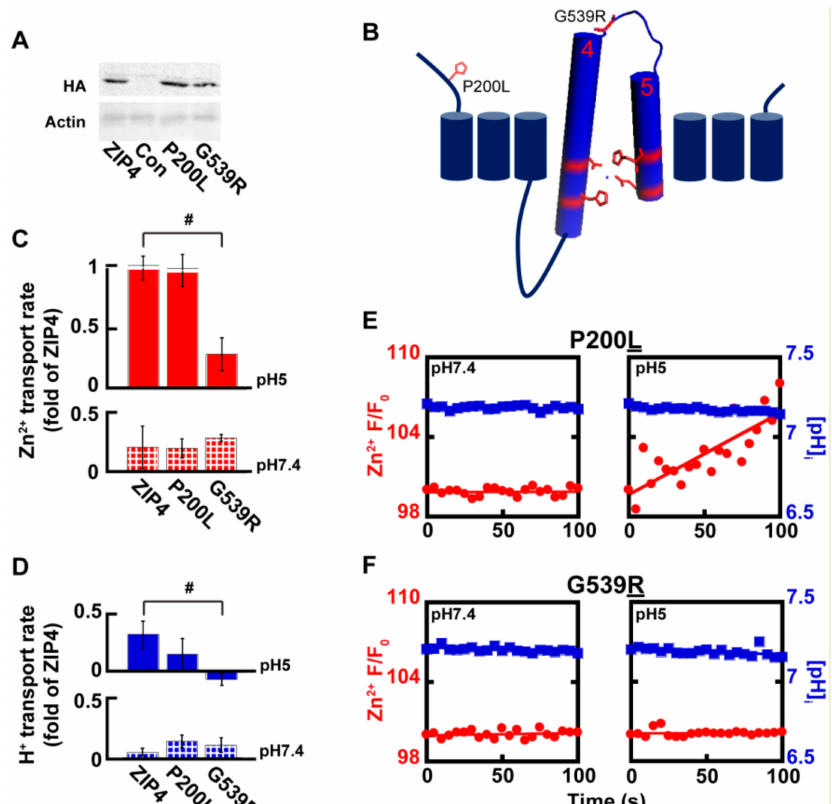
Figure 5. Genetic variations in ZIP4 a ff ect catalytic and non-catalytic domains. ( A ) Immunoblot analysis of Acrodermatitis enteropathica (AE)-associated ZIP4 constructs, as indicated, from HEK293-T cell lysates. ( B ) Membrane orientation of ZIP4 illustrates the position of AE-associated variants P200L and G539R. ( C ) Normalized rates of Zn 2 + uptake at pH7.4 (bottom panel—striped) and pH5 (top panel—filled), mediated by AE-associated ZIP4 mutants, in HEK293-T cells loaded with Fluozin-3AM N ≥ 5. ( D ) Normalized rates of H + uptake at pH 7.4 (bottom panel—striped) and pH5 (top panel—filled), mediated by AE-associated ZIP4 mutants, in HEK293-T cells loaded with BCECF-AM. ( E – F ) Representative traces of Zn 2 + (red) and H + uptake (blue) recorded in HEK293-T cells transfected with ZIP4 P200L ( E ) and ZIP4 G539R ( F ) n ≥ 3. In ( C ) and ( D ), # is p ≤ 0.05 between cells expressing ZIP4 and G539R mutant at